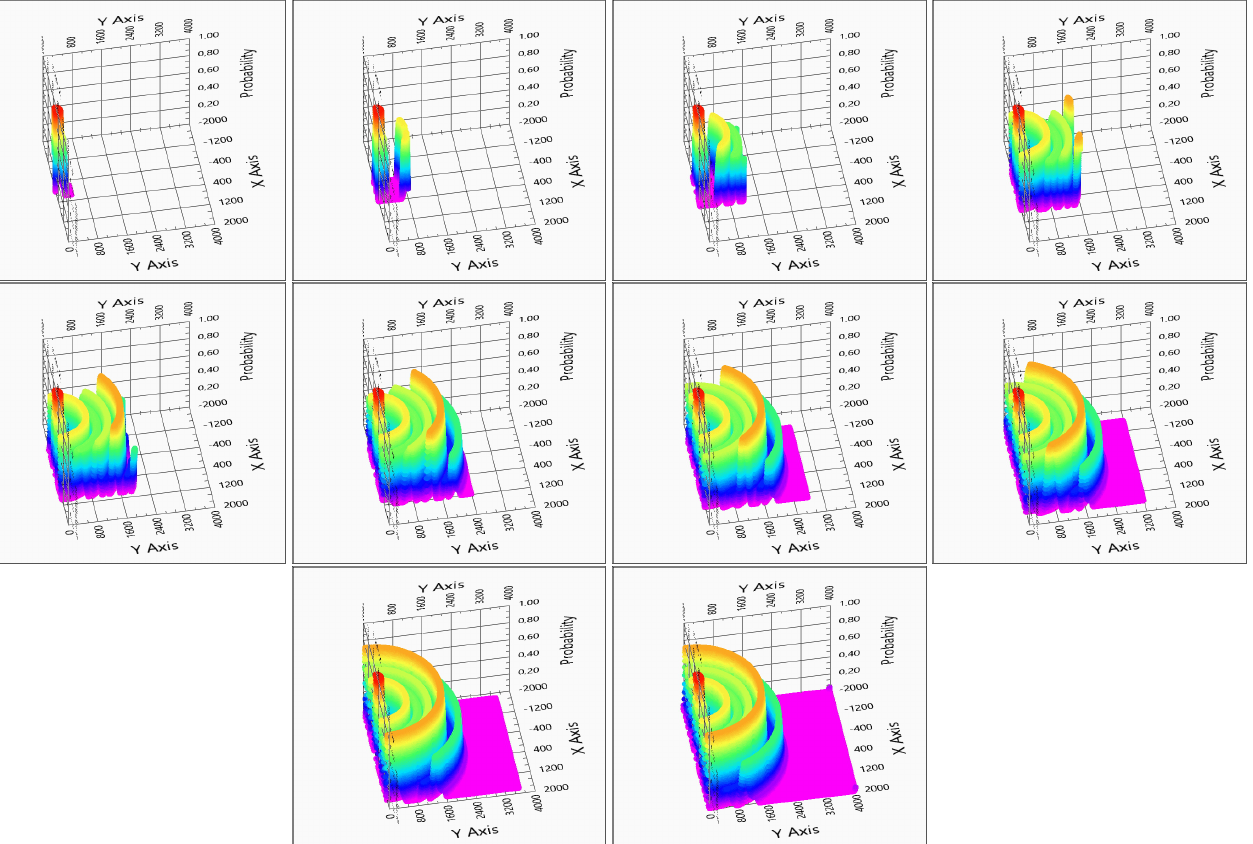
Figure 7. The resulting probability distributions of the occupation of the space with 1 sensor for the reference measurement. The different subplots correspond to the different number of evaluated points, i.e., the different size of the evaluated area as listed in the first column of Table A5. The evaluated area varies from 401 by 401 to 4001 by 4001—the grid density did not